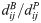
Numbers of opened facilities corresponding to different dijB/dijP.